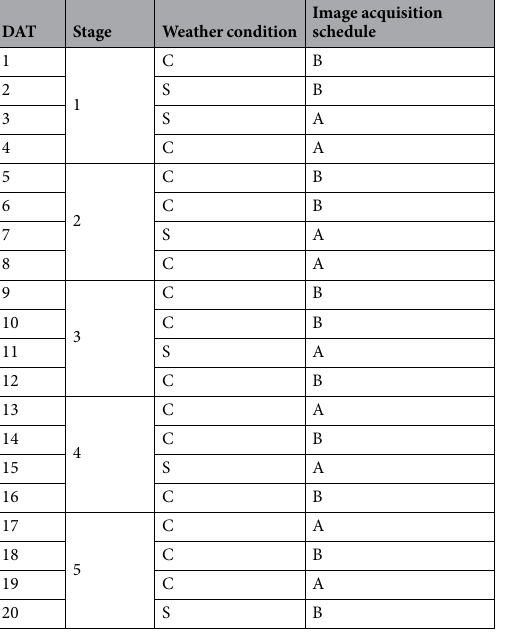
Table 5. Weather condition and image acquisition schedule during growing period. Note: DAT - days after transplanting, S - sunny, C - cloudy; A: image acquisition scheduled from 6:00 h to 18:00 h at 2 h intervals; B: image acquisition scheduled only at 14:00